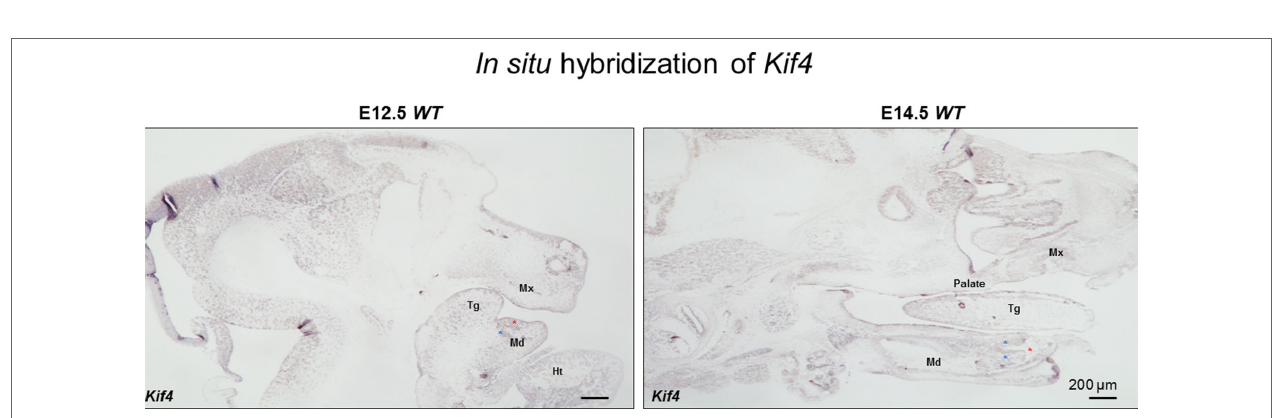
FIGURE 2 | Migration scratch assay. HEPM cells were seeded at high density 24 h after Kif4 α Wild-type & Kif4 α Mutant transfection. Pictures at 0, 4, 8, 20, and 30 h after scratch. The number of cells between the red lines were counted in the different groups. Box plots of the number of cells in the scratched area at the different time points.